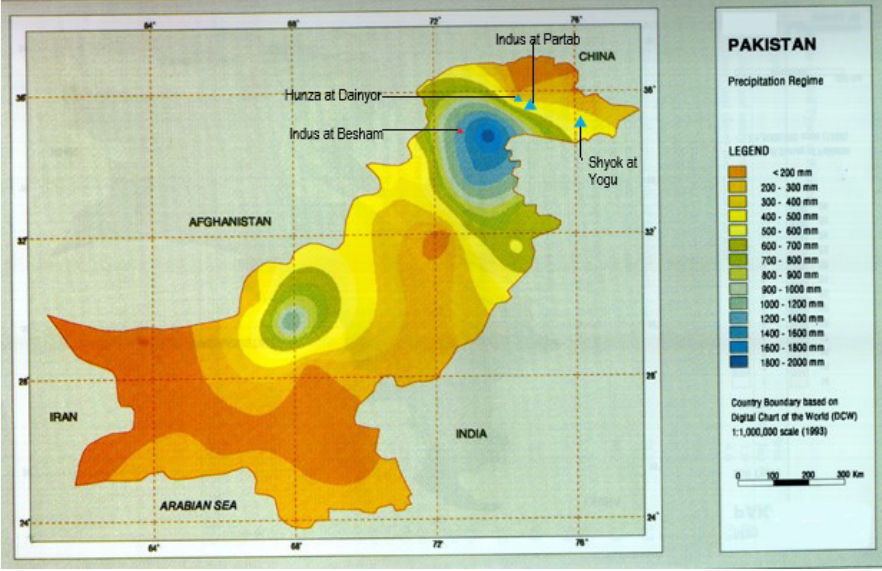
Figure 2. Normal precipitation regime of Pakistan (including upper Indus